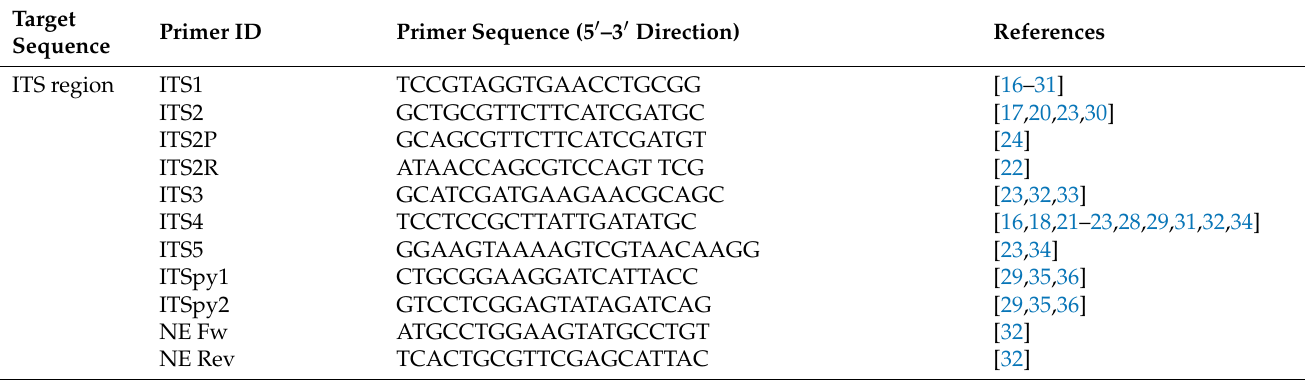
Figure 2. Nucleic acid-based tests established for P. insidiosum detection. Abbreviations: PCR, polymerase chain reaction; HDA, helicase-dependent amplification; LAMP, loop-mediated isothermal amplification; mNGS, metagenomic next-generation sequencing; WGS, whole-genome sequencing. Table 1. Primer sequences used in NATs for the detection of P. insidiosum .